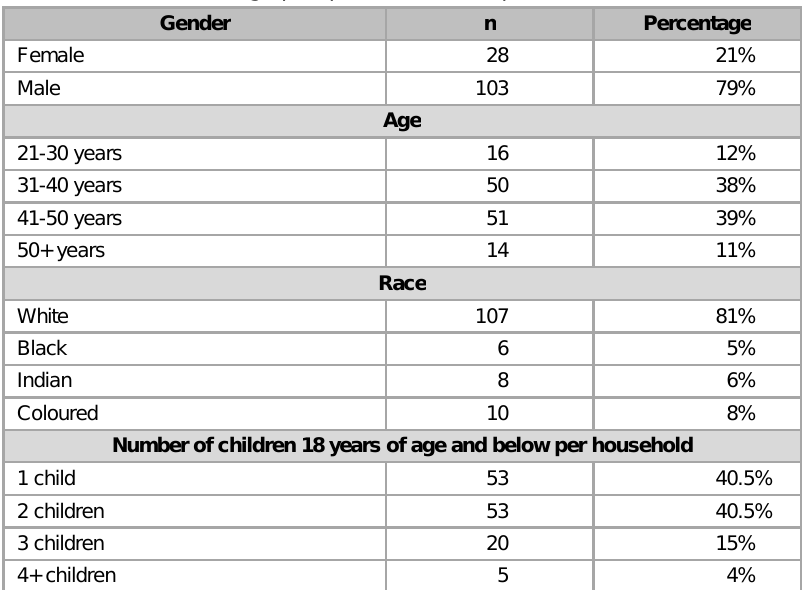
Demographic profile of the sample